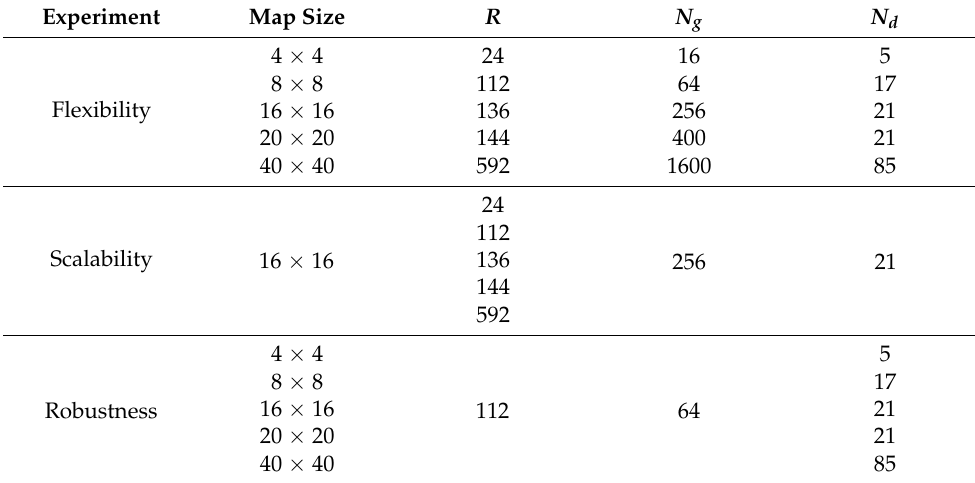
Table 3. Experimental